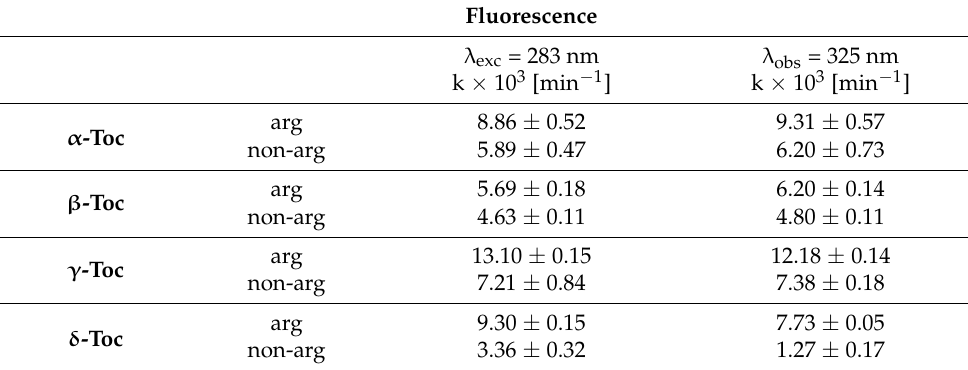
Table 1. Photooxidation rate constants of tocopherols in